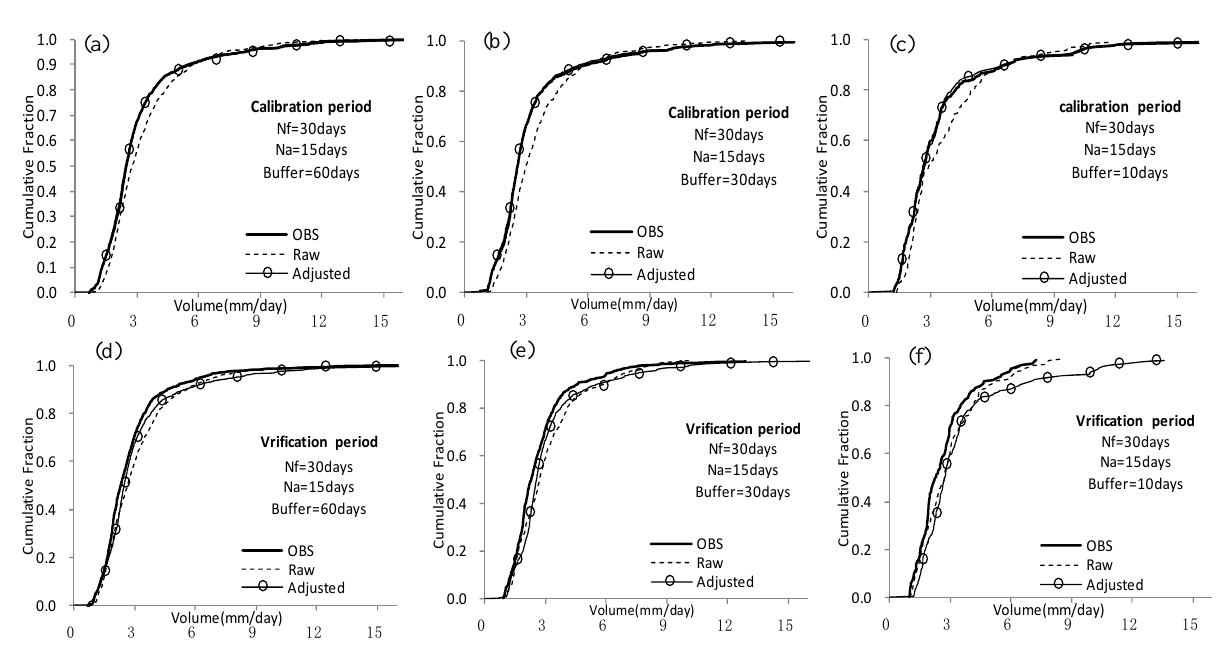
Fig. 6. The effects of different settings for data window on GLMPP results.